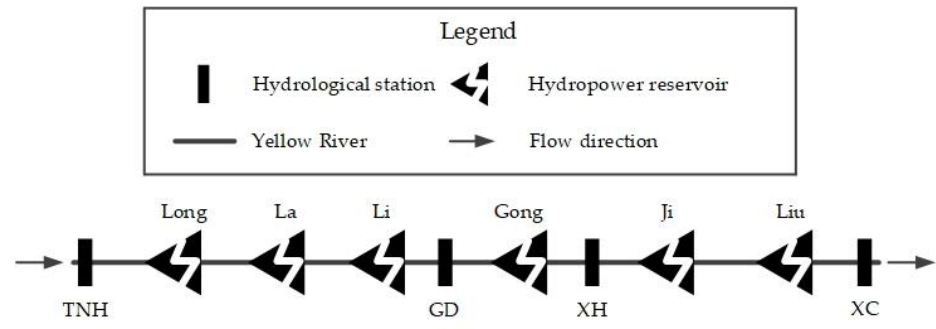
Figure 3. Relative locations of hydrological stations and hydropower reservoirs at the UYR. Table 1. Characteristic water levels of Long and Liu reservoirs.